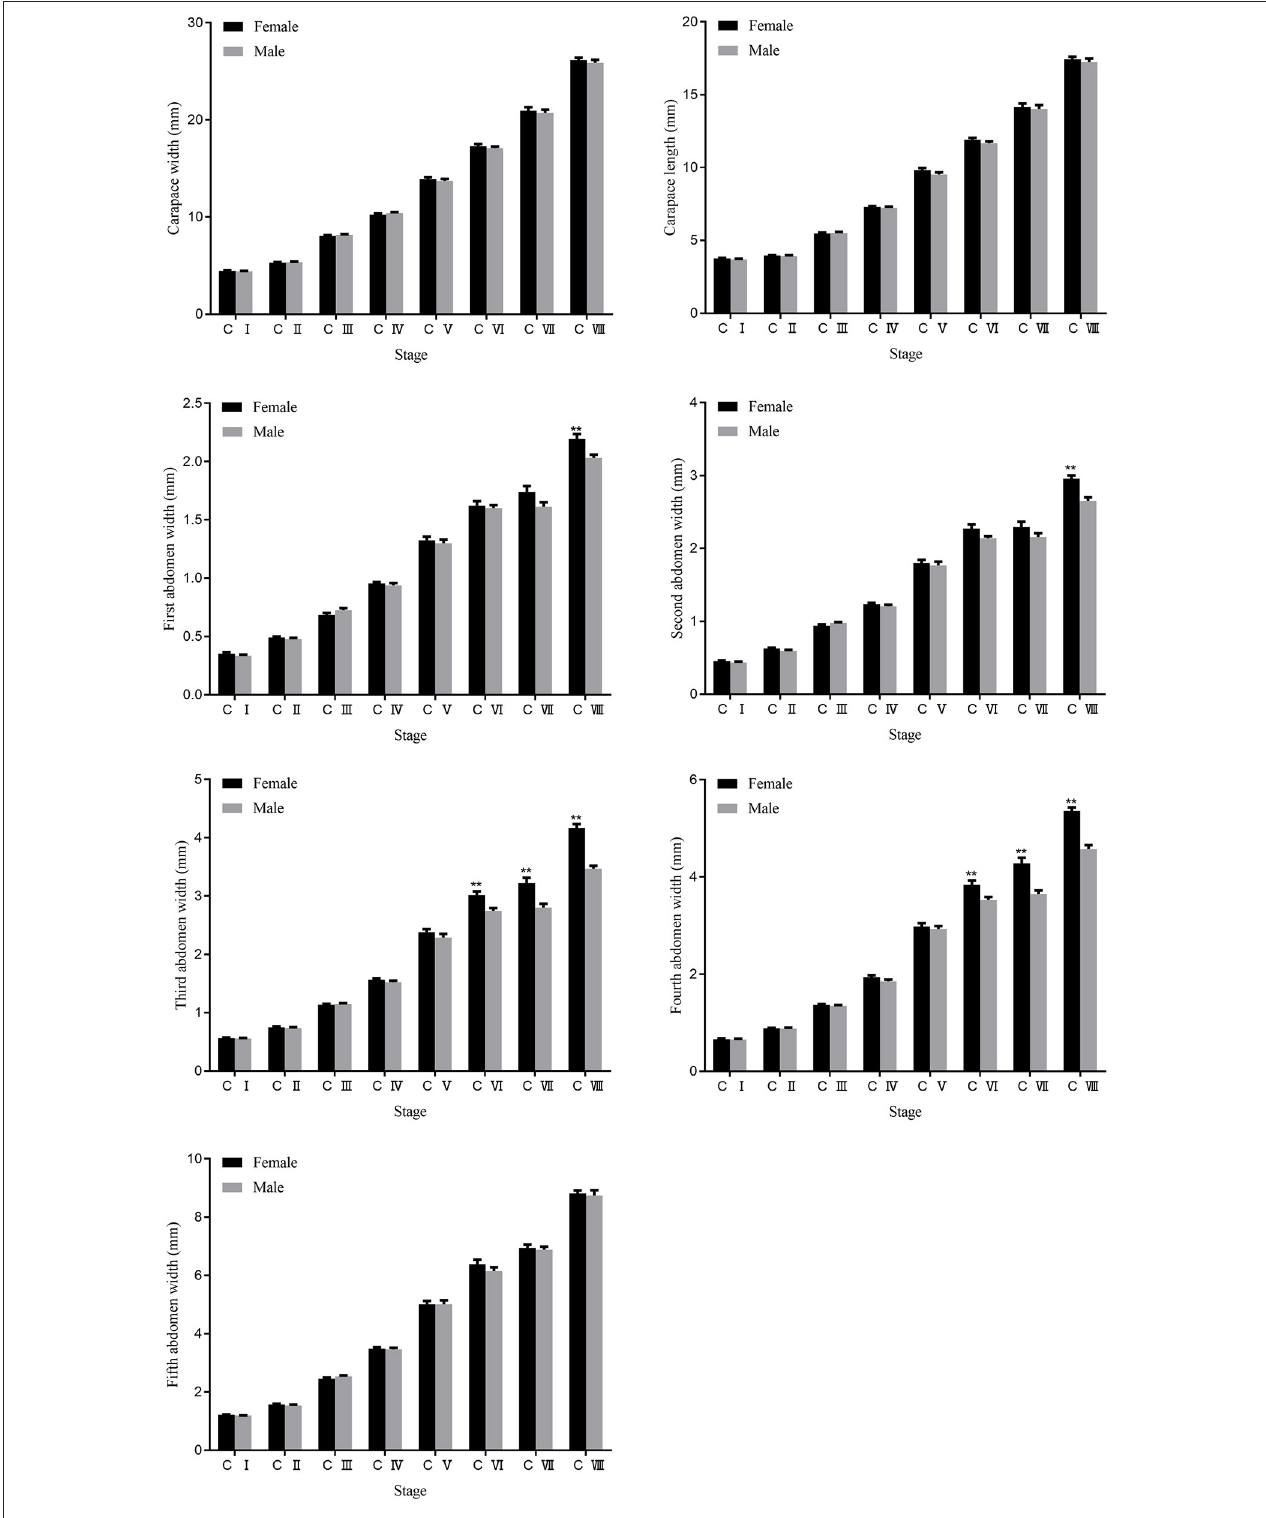
FIGURE 3 | Changes and differences of seven traits between females and males during the development of the S. paramamosain crablets. ** represents significant differences at 0.01 level. C I, C II, C III, C IV, C V, C VI, C VII, and C VIII represent crablets of stages I, II, III, IV, V, VI, VII, and VIII. AW1, first abdomen width; AW2, second abdomen width; AW3, third abdomen width; AW4, fourth abdomen width; AW5, fifth abdomen width.